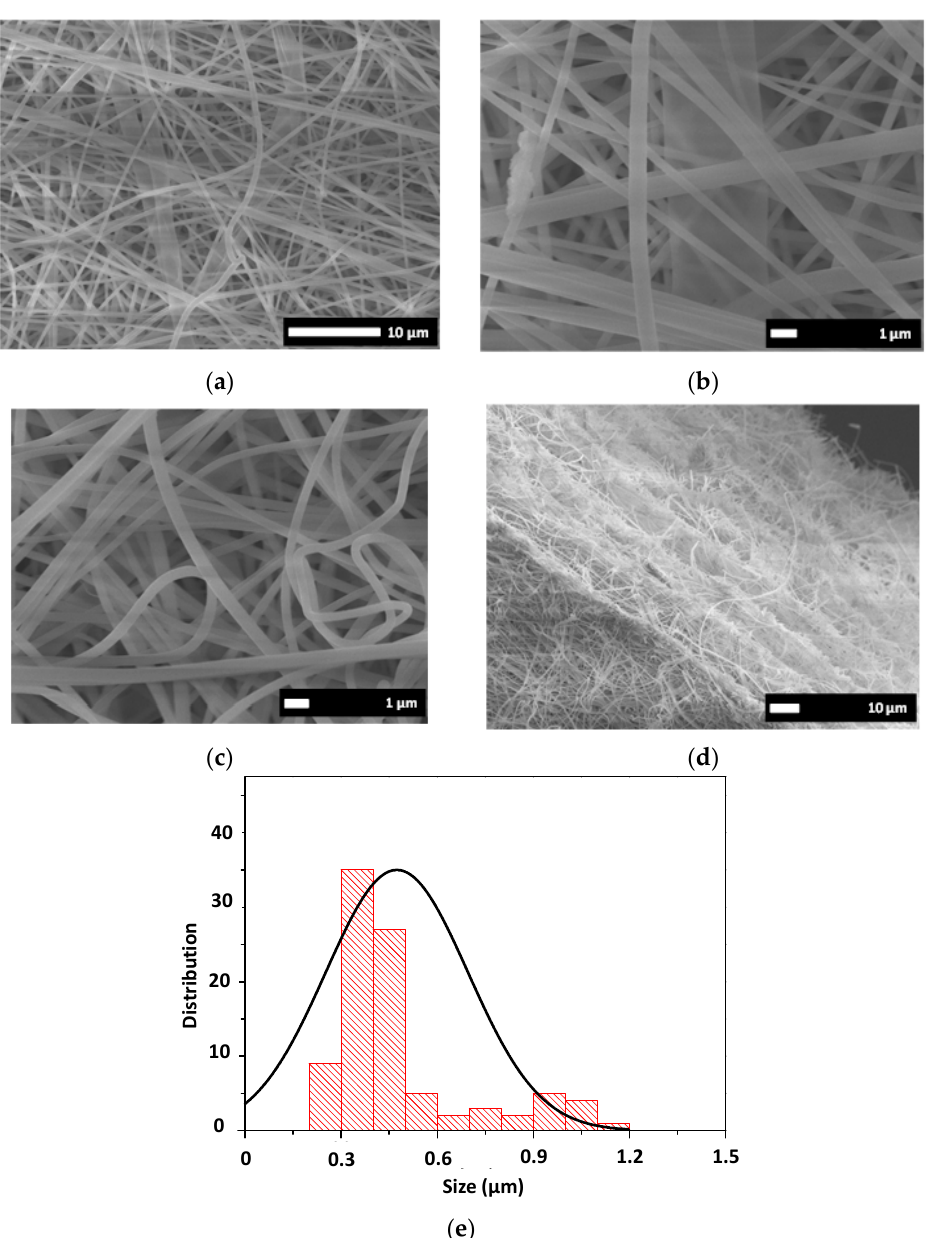
Figure 4. SEM images for the electrospun mat (NFm- 6 ) formed from polymer blends PVP/TS-PIL 6 at different magnification. Surface view ( a – c ) and section view ( d ). Scale bar represent 10 μ m ( a , d ) and 1 μ m ( b , c ). ( e ) NFs size distribution.